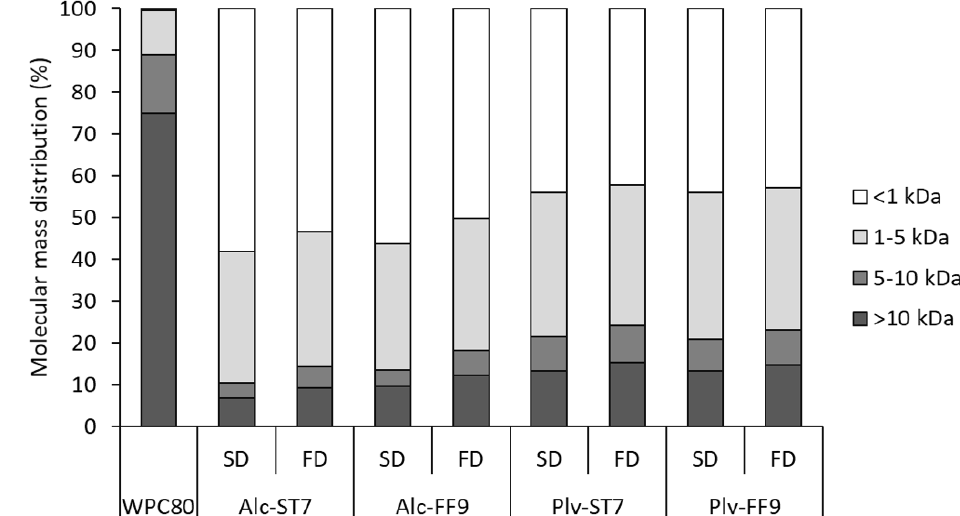
Figure 3. Molecular mass distribution profile of whey protein concentrate (WPC80) and spray-dried (SD) and freeze-dried (FD) whey protein hydrolysates prepared using Alcalase ® (Alc) and Prolyve ® (Plv) obtained under pH-stat at pH 7.0 (ST7) and free-fall pH 9.0 (FF9) hydrolysis conditions. There were some differences in the molecular mass distribution profiles of the WPHs depending on the drying process used (SD vs. FD). In general, the SD-WPHs contain a greater amount of low molecular mass components (<1 kDa) than the FD-WPHs, partic- ularly in the case of Alcalase hydrolysates. For instance, the Alc-ST7 contained 58% and 53% of peptides <1 kDa in the SD and FD samples, respectively (Figure 3). These results pupae protein hydrolysate had a higher proportion of peptides < 1 kDa (83.6%) compared